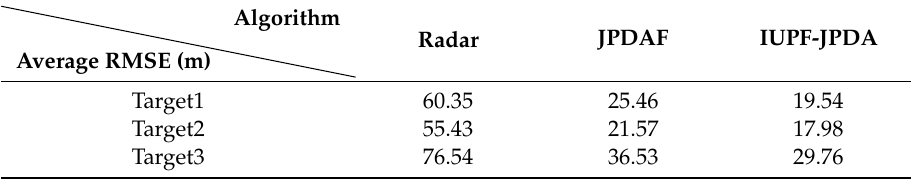
Figure 13. Comparison of position RMSE for target 3 in a multi-target simulation experiment. Table 4. Comparison of average data in a multi-target simulation experimen t.